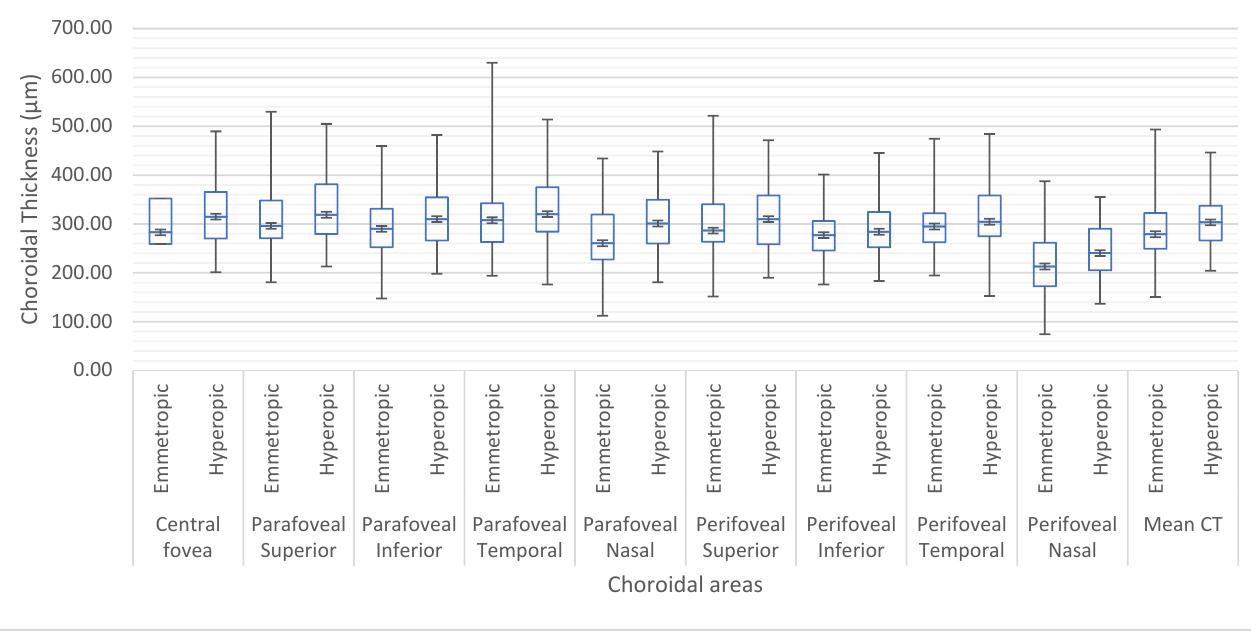
Figure 3. Median CT in each choroid area in different study groups.